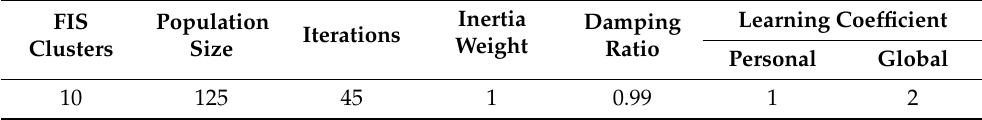
Table 4. The used parameter characteristics for PSO in this study.